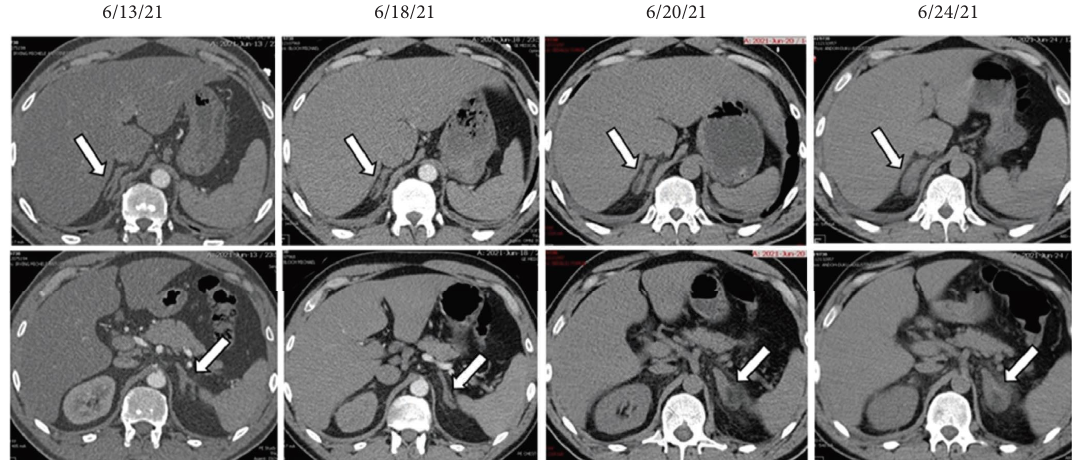
Figure 1: Evolution of the right (frst row) and left (second row) adrenal gland